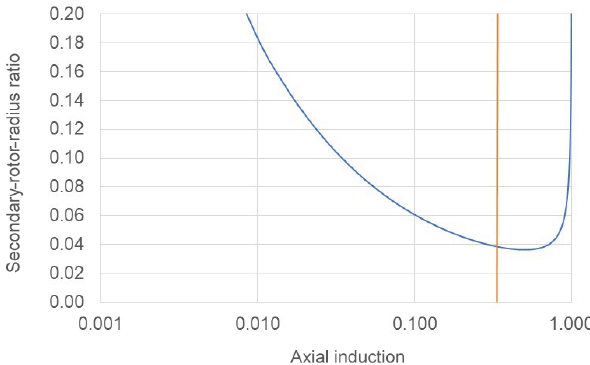
Figure 9. Ratio of secondary-rotor radius to that of primary rotor.